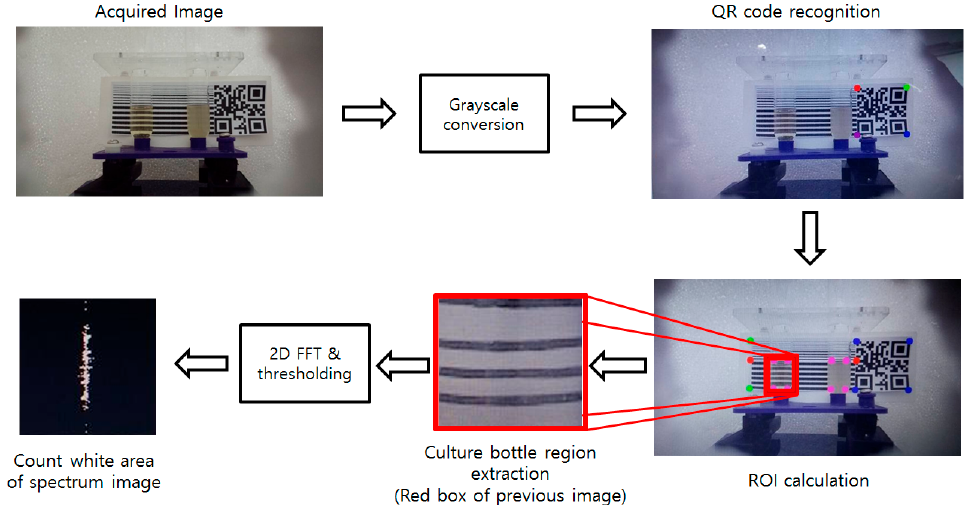
Figure 2. Flow chart describing the proposed image processing algorithm. Dots in the images indicate the recognized corners of the QR code and striped regions.